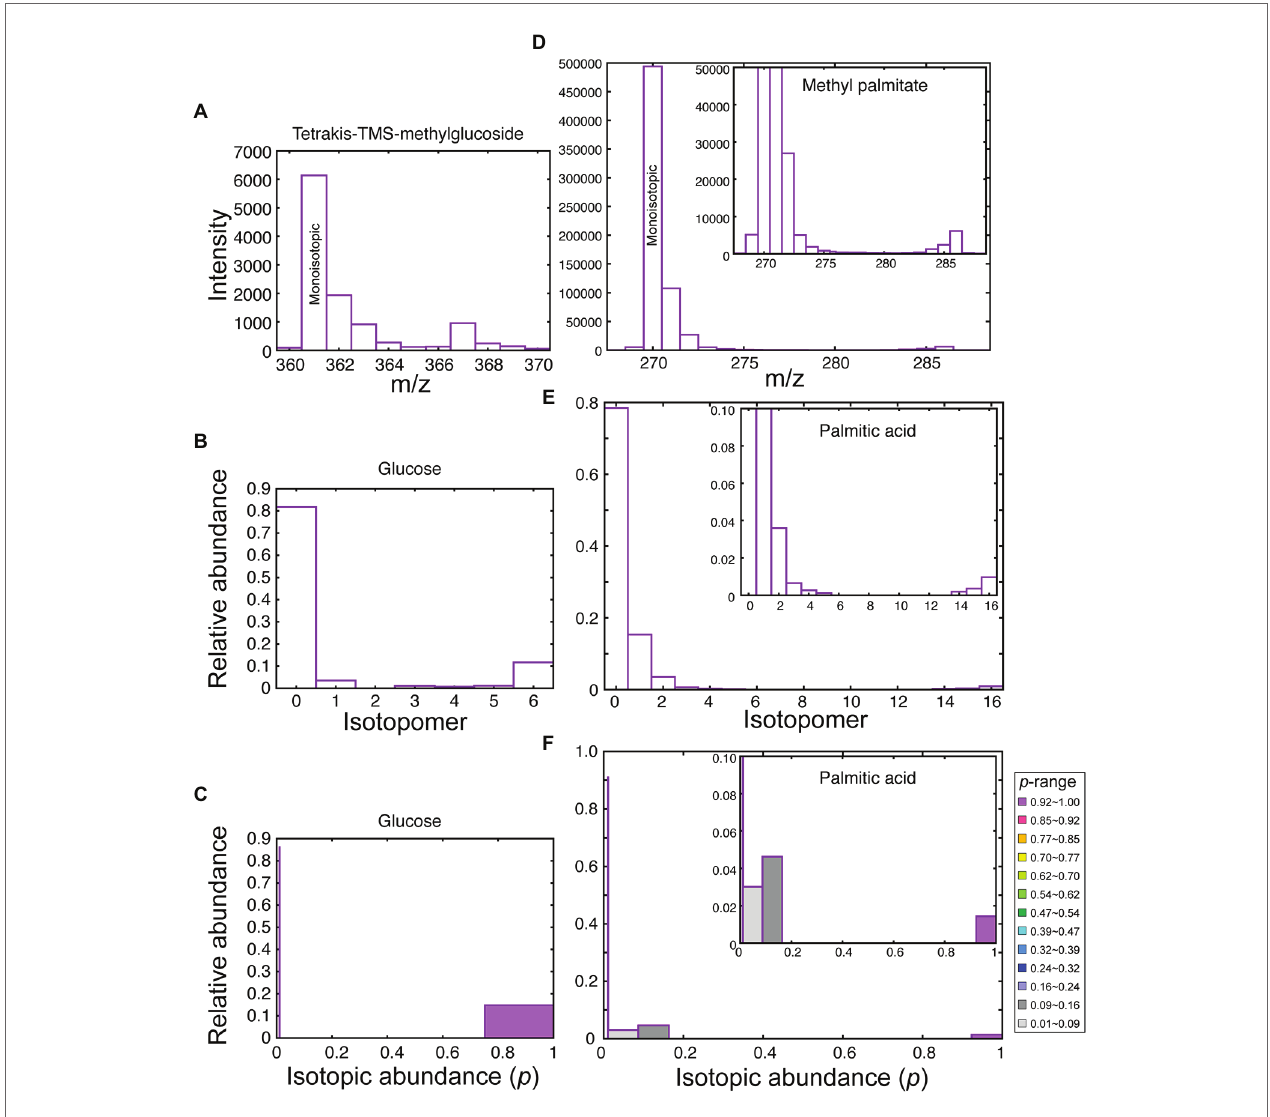
FIGURE 2 | Data processing in isotopomer analysis. (A) Mass spectrum of the fragment ion having the monoisotopic m/z = 361 from tetrakis (TMS) methylglucoside (from starch after 2-h labeling with [ 13 C]bicarbonate at the exponential growth phase, 48 h after innoculation). (B) Isotopomer distribution of glucose. (C) Distribution of isotopic abundance, estimated according to the band model of C13dist software, using four steps having the width of 0.247 plus the natural abundance ( p = 0.0108) population. (D) Mass spectrum of the molecular ion of methyl palmitate (from TAG after 5-h labeling with [ 13 C]bicarbonate followed by 4 days chase). (E) Isotopomer distribution of palmitate. (F) Distribution of isotopic abundance, estimated according to the band model, using 14 steps having the width of 0.0707 plus the natural abundance population. Inset in (D–F) shows an